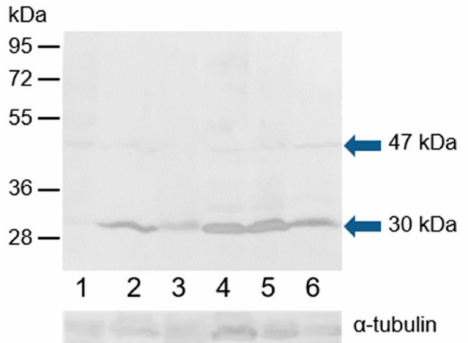
Figure 10. Reaction of anti-ESR2 (H-150) with proteins extracted from bull spermatozoa. Western blotting with antibody H-150 was performed to analyze bull spermatozoa proteins after protein separation by SDS-PAGE (12% gel) under reducing conditions. 1, spermatozoa from the caput epididymis; 2, spermatozoa from the corpus epididymis; 3, spermatozoa from the cauda epididymis; 4, freshly ejaculated spermatozoa; 5, spermatozoa after in vitro capacitation; 6, spermatozoa after the acrosome reaction. The arrows indicate di ff erent isoforms of ESR2. The protein concentration in sperm samples was checked by α -tubulin